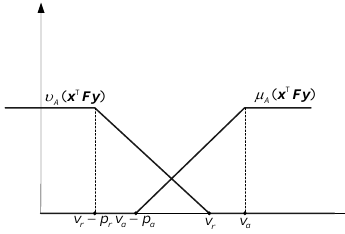
Fig.1. Player I’s IF-set